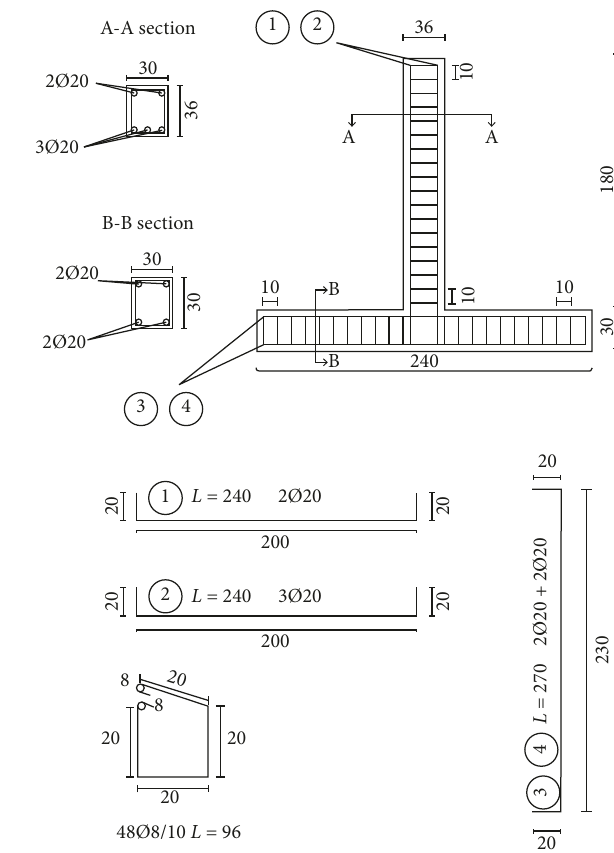
2: Design of reinforced concrete beam-column for the control